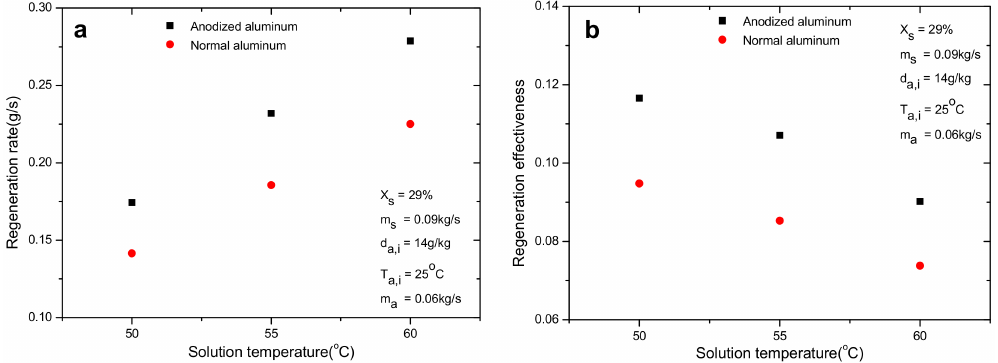
Figure 5. Comparison of regeneration performance between different regenerators: ( a ) regeneration rate ( b ) regeneration